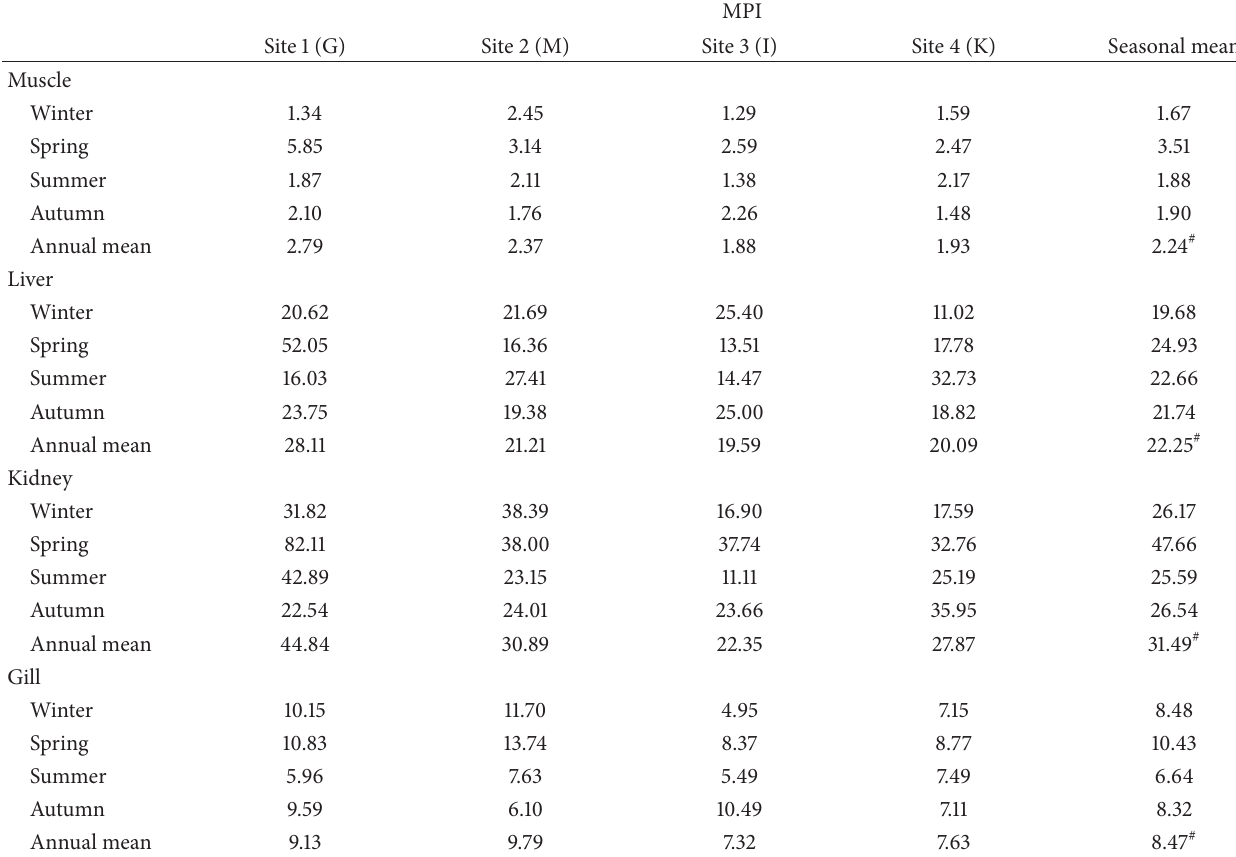
Table 2: Metal pollution index (MPI) of total trace metals in vital organs of O. niloticus